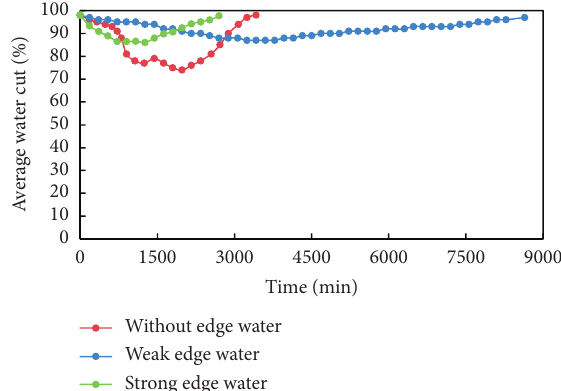
Figure 5: Curves of the average water cut under different edge water energy